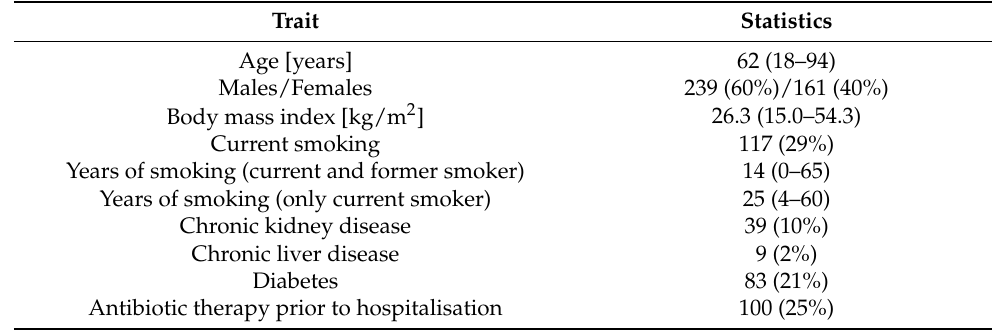
Table 1. Overview of patient characteristics. Statistics are presented as median (minimum to maxi- mum), respectively, absolute numbers (percentages). Total number of patients with cytokine mea- surement at baseline is N =